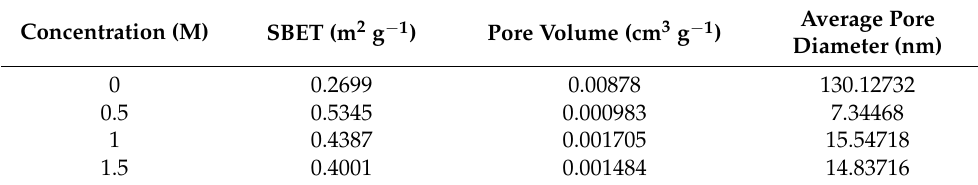
Table 2. Surface properties of palm empty fruit bunch membrane adsorber.